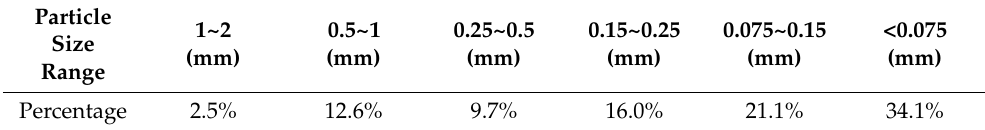
Table 1. Particle size distribution of the soil samples.